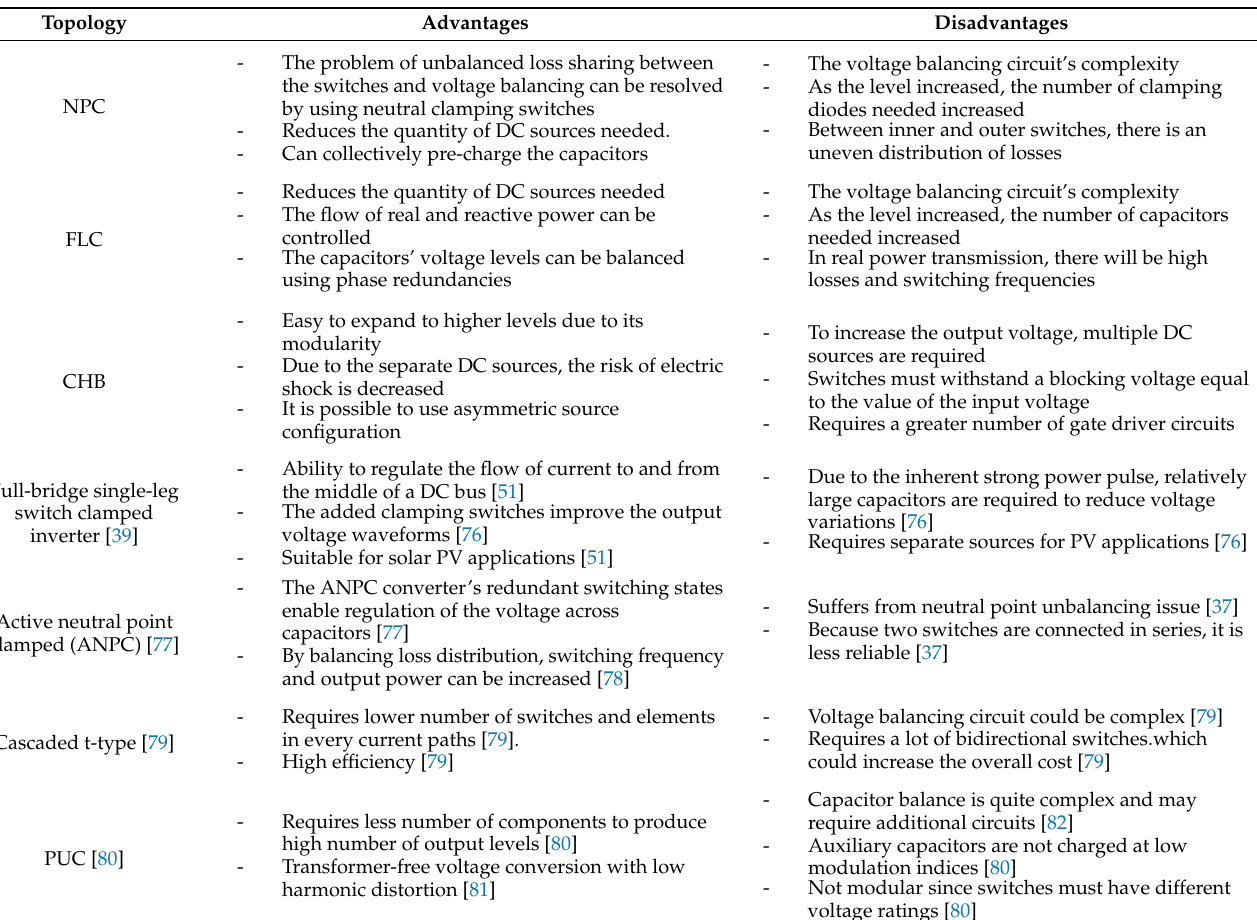
Table 3. Advantages and disadvantages of various